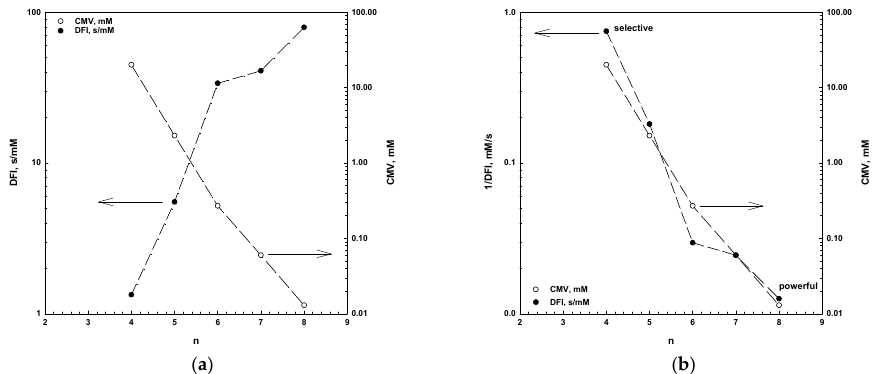
Figure 15. Effect of the number of carbons in the alkyl chain ( n ) of aliphatic alcohols on CMV and DFI: ( a ) DFI and CMV vs. n ; ( b ) 1/DFI and CMV vs n .